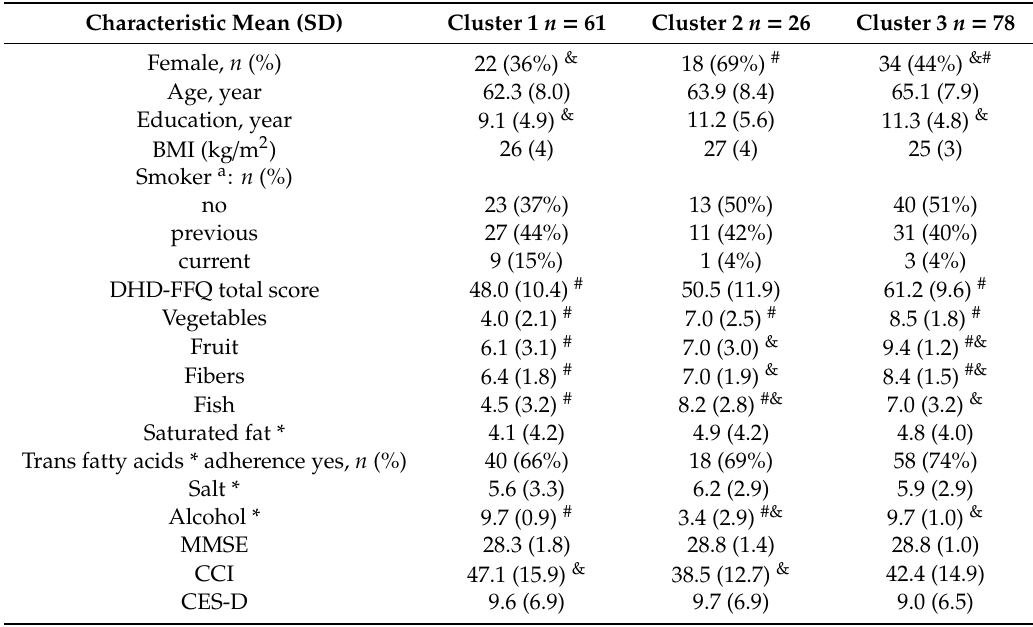
Table 4. Group comparisons between the 3